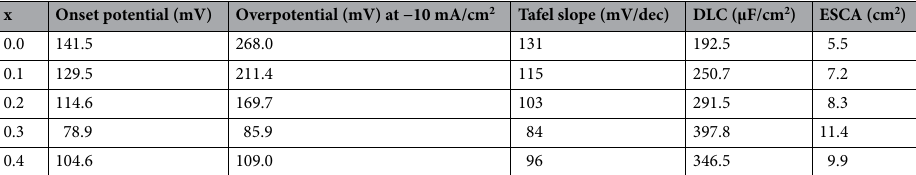
Table 2. HER parameters for different catalysts of V x -MnCo (x ≤ 0.4) MCs